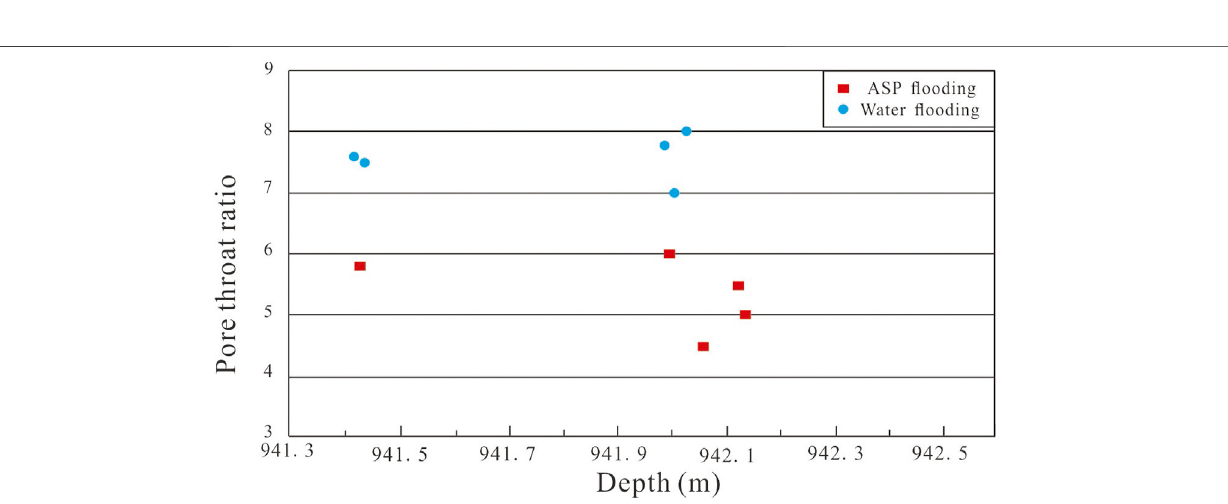
FIGURE 6 | Variation characteristics of pore – throat ratio before and after ASP fl ooding.